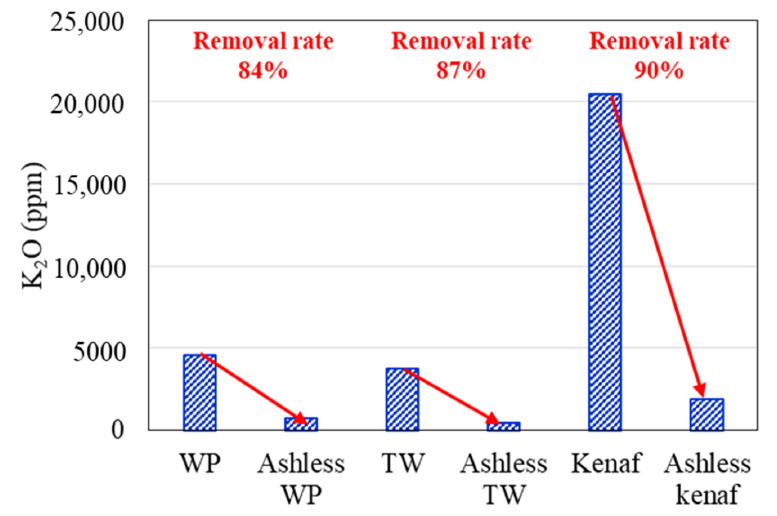
Figure 6. K 2 O contents of three biomass types before and after the ALB treatment.